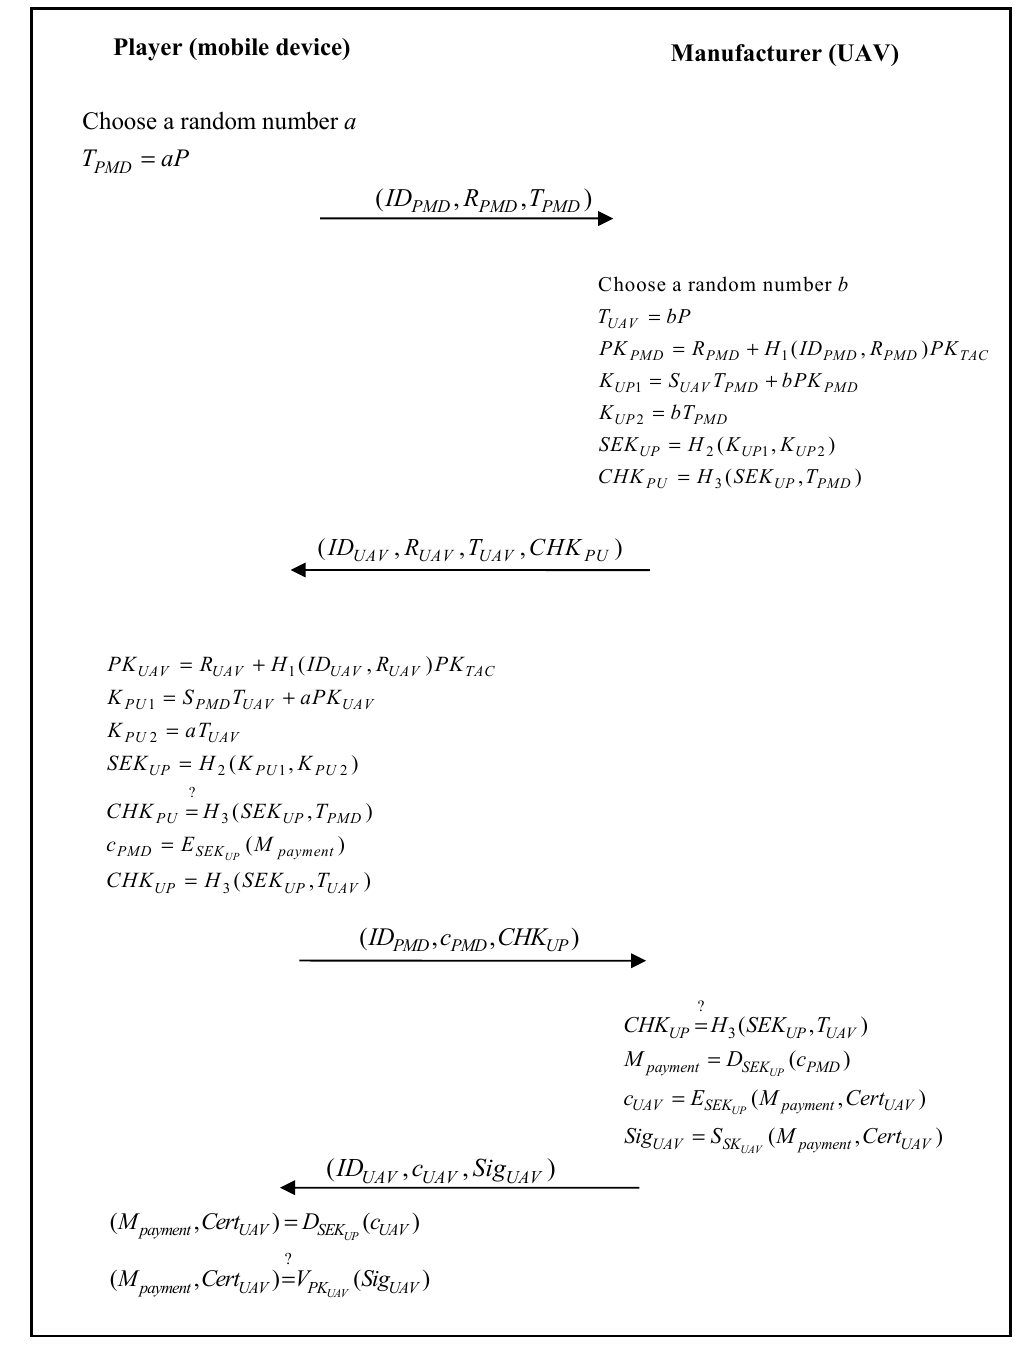
Figure 5. Player and manufacturer authentication and communication phase of the proposed scheme.